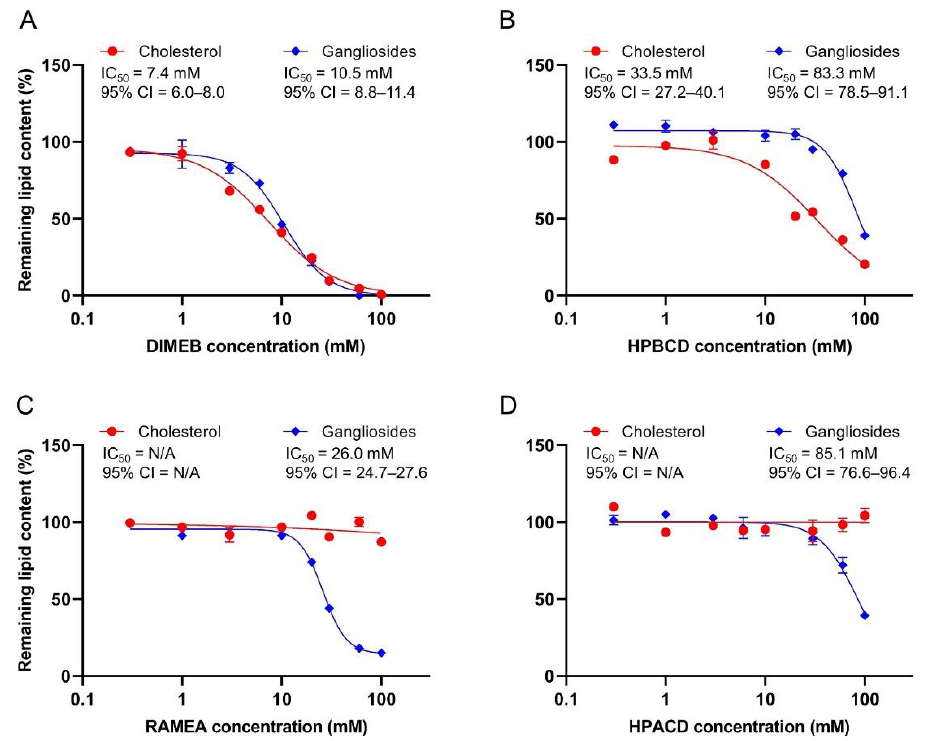
Figure 1. The effect of DIMEB ( A ), HPBCD ( B ), RAMEA ( C ), and HPACD ( D ) on the ganglioside and cholesterol content of the rat cerebral synaptosomes. Lipid levels were measured after 40 min of exposure of the synaptosomes to cyclodextrins. Values are expressed as the percentage of vehicle- treated synaptosomes. The IC 50 values and their 95% confidence intervals (95% CI) are given. Data are represented as the means ± SEM (n = 3). N/A means non applicable.